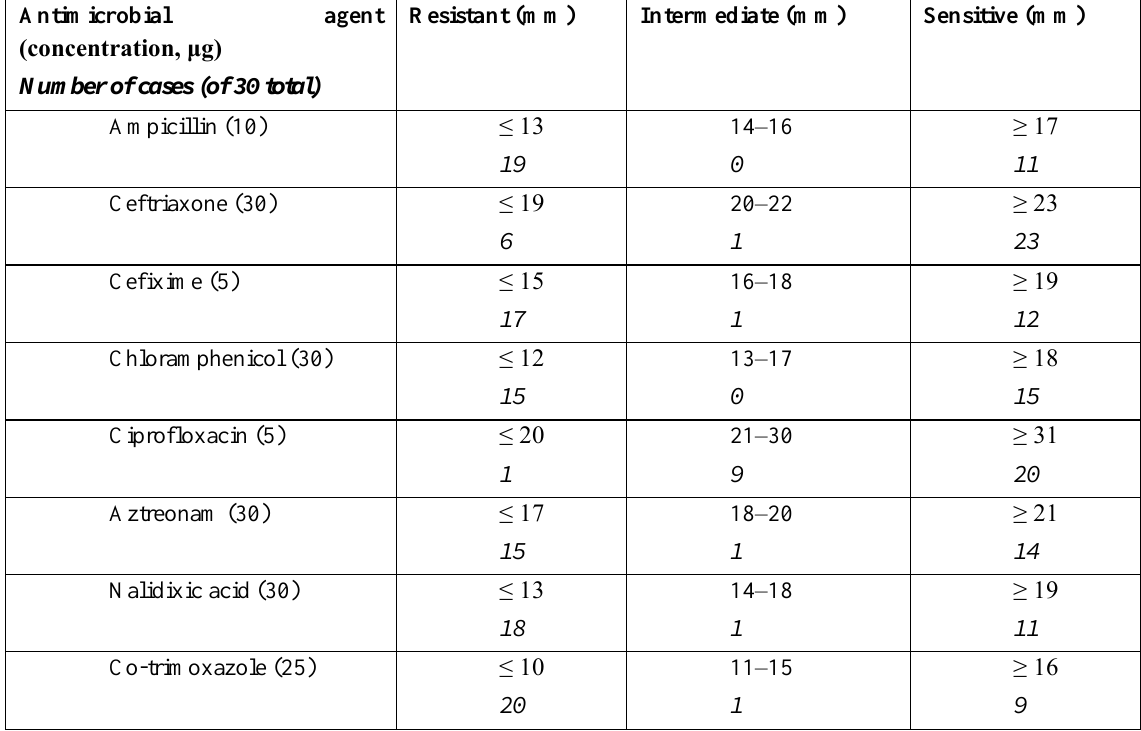
Table 3. Sensitivity of S. Typhi to selected antibiotics by the Kirby-Bauer disc diffusion method. Interpretation followed CLSI guidelines [30]. Case numbers showing resistance, partial or total sensitivity to each antibiotic are indicated in italics.